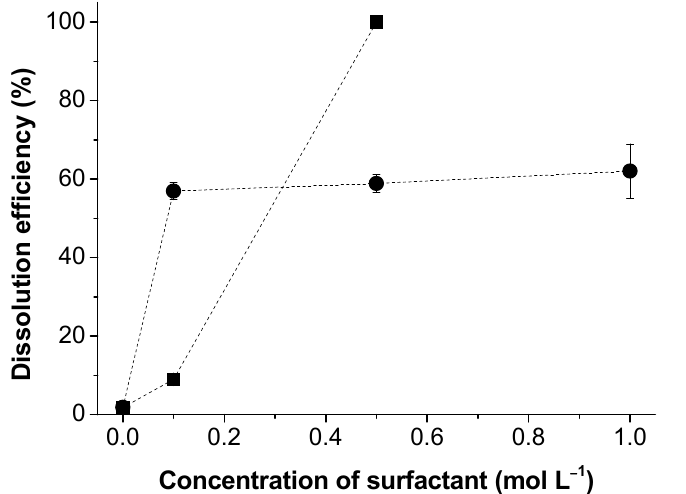
Figure 5. Dissolution efficiency of kraft lignin as a function of polysorbate 20 (PS20) (squares), and Triton X-100 (TX-100) (circles).